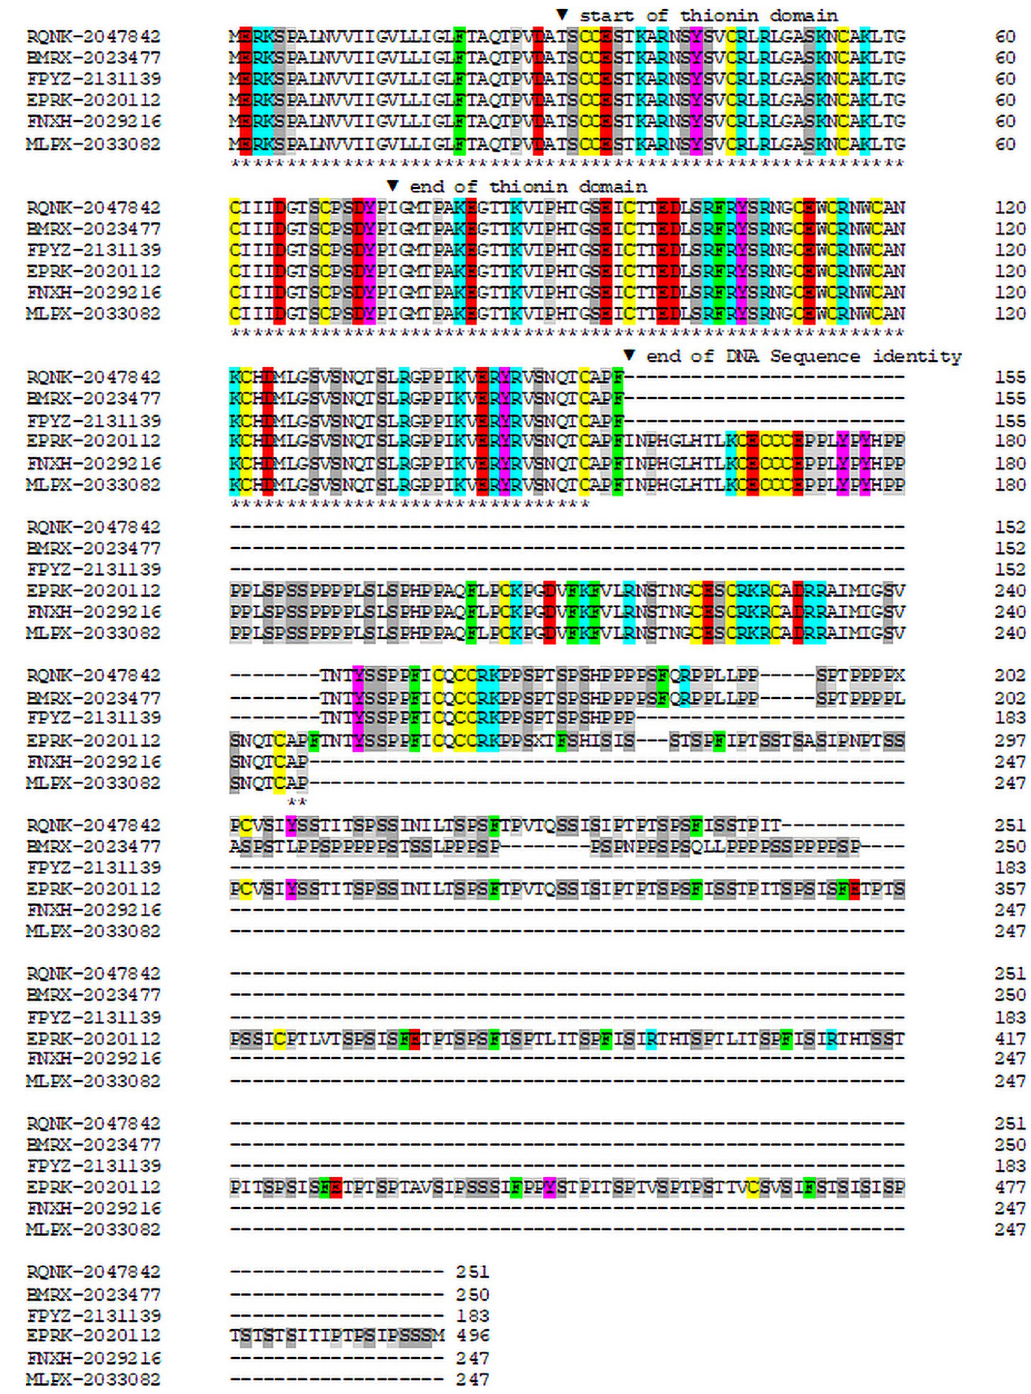
Fig 4. Alignment of Papaver thionin preproproteins with unusual pro domains. RQNK-2047842, BMRX-2023477 and FPYZ-2131139 are from P . somniferum (PsoTHI2.1) while EPRK-2020112, FNXH-2029216 and MLPX-2033082 are from P . setigerum (PseTHI2.1). Cysteine yellow, basic amino acids blue, acidic amino acids red, tyrosine pink, phenylalanine green, proline grey, serine dark grey.